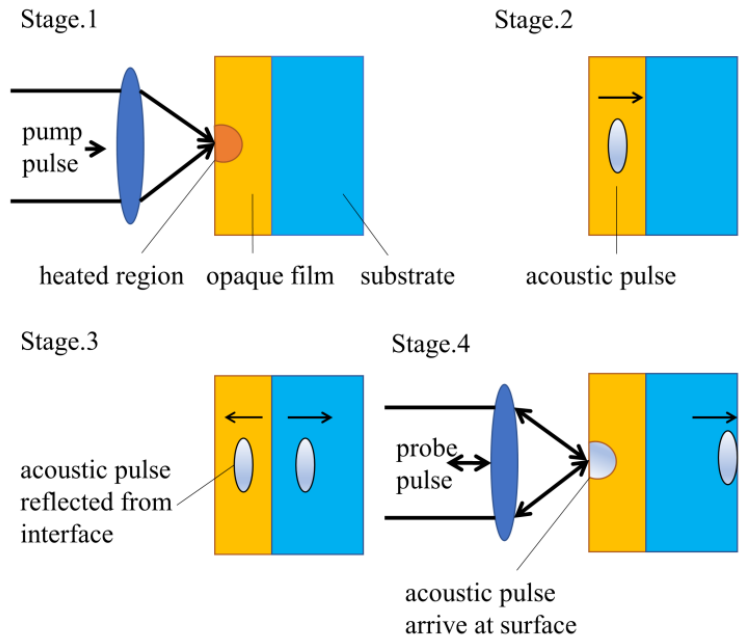
Figure 1. Sequence of events in opaque